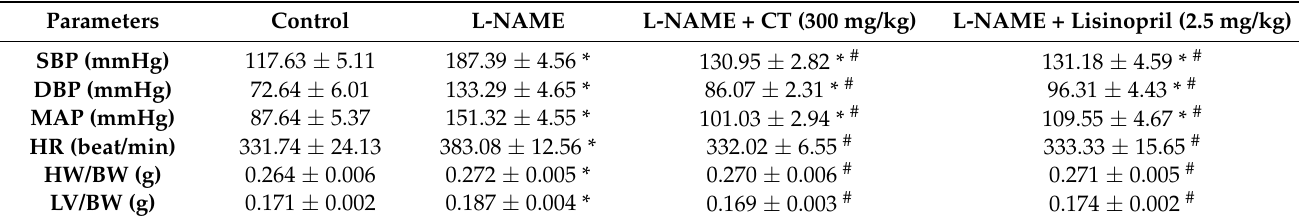
Table 2. Effects of CT extract and lisinopril on blood pressure, heart rate, heart weight per body weight, and left ventricular weight per body